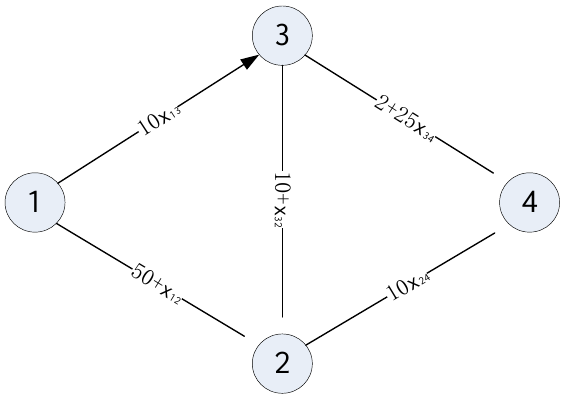
Figure 1 Network of Braess’